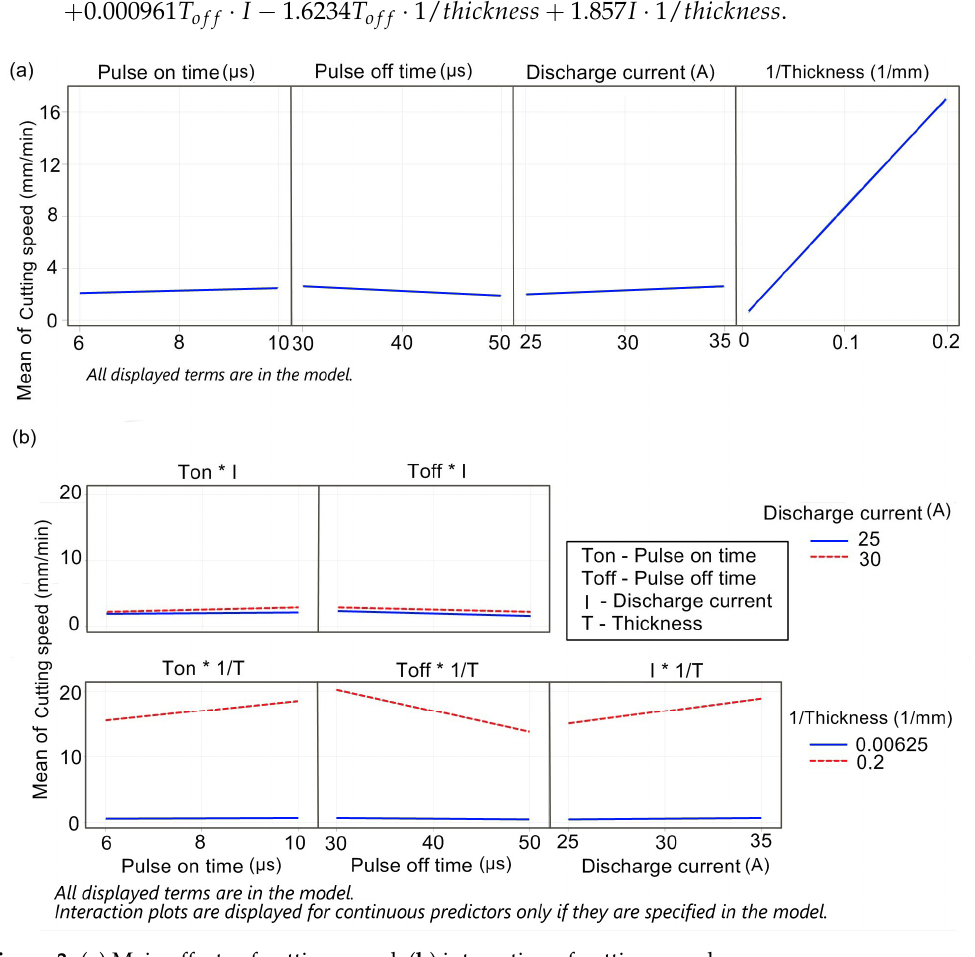
Figure 3. ( a ) Main effects of cutting speed, ( b ) interaction of cutting speed.